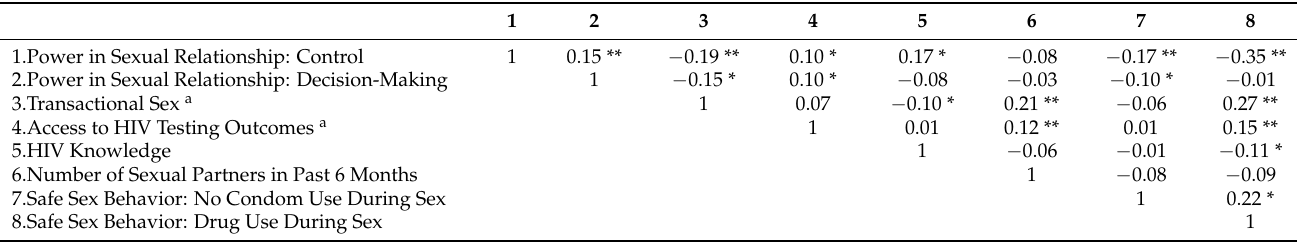
Table 2. Correlation matrix among main analytic variables ( N = 322).